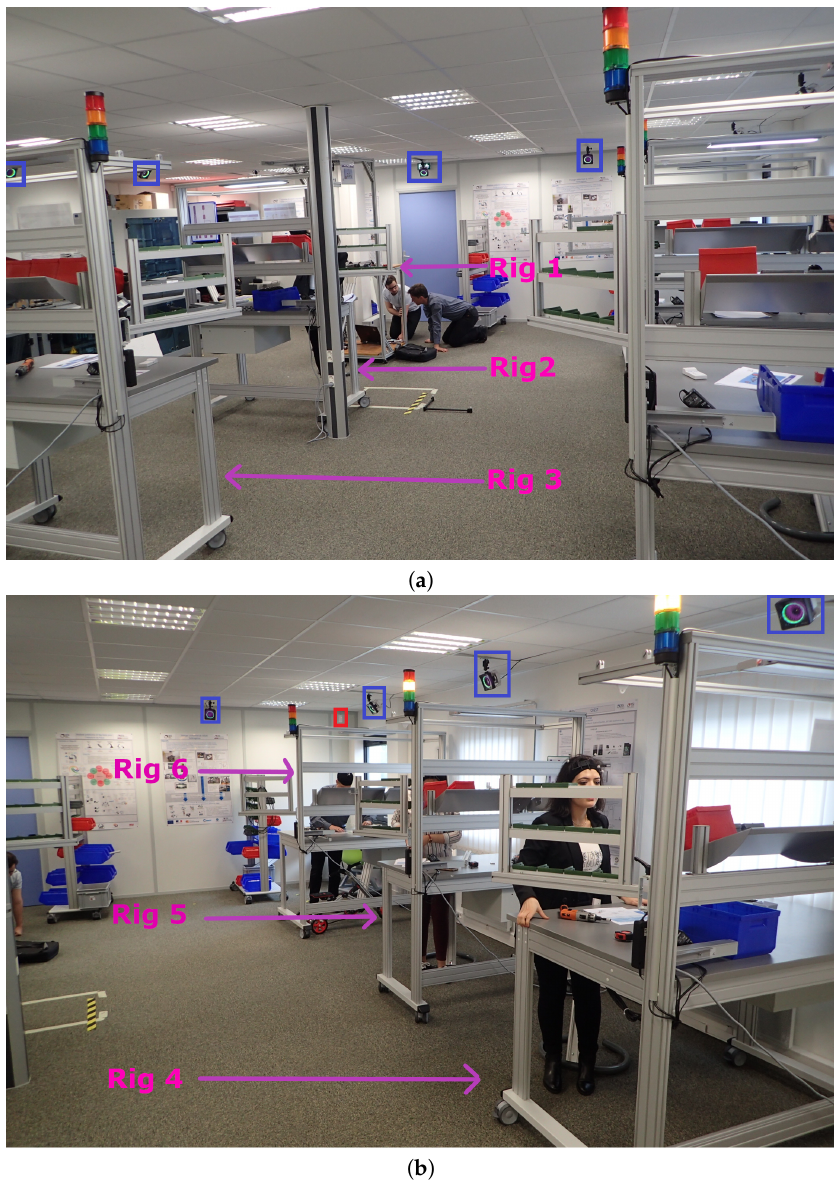
Figure 2. Our UWB set-up in an industrial NLOS assembly line. In the blue squares are the MoCap system and in red square the UWB system when not hidden due to NLOS conditions. ( a ) Industrial set-up in non-line-of-sight (NLOS) with six assembly rigs. view [A]. ( b ) Industrial set-up in NLOS with six assembly rigs. view